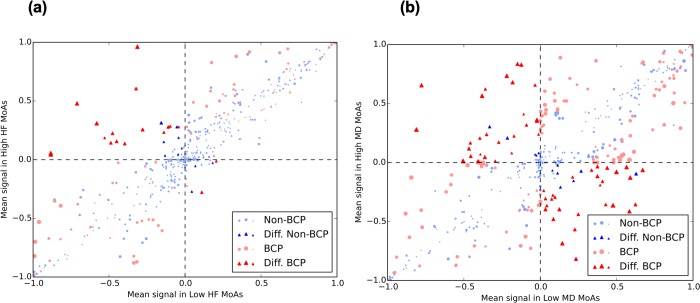
Scatter plot of the mean signal values of Low and High-“disease” Mechanisms of Action (MoA).Scatter plot of the mean signal values of Low-“disease” and High-“disease” MoAs for each protein using as disease Heart Failure (HF) in (a) and Macular Degeneration (MD) in (b). The average of the output signal of each protein in High-group is presented versus its value in Low-group. Differential signals (Diff., shown as triangles) are defined as those with opposite sign when comparing High versus Low average, and a p-value < 0.01 when calculating the Mann-Whitney U test between the two distributions of signals. Best-classifier proteins (BCP) are colored in red, otherwise they are blue. Sizes of markers are proportional to p-values of the Mann-Whitney U test.